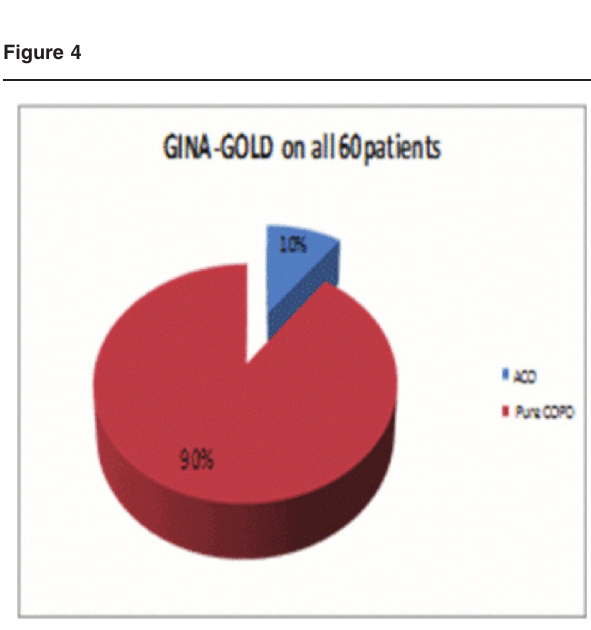
Applying the GINA-GOLD criteria on all patients with COPD. COPD, chronic obstructive pulmonary disease; GINA-GOLD, Global Initia- tive for Asthma-Global Initiative for Chronic Obstructive Lung Dis-